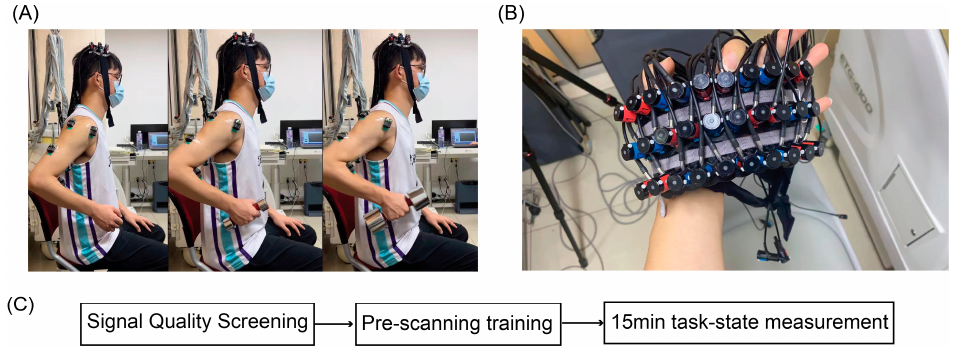
Figure 1. ( A ) Actual scenes of the experiment. The subject is seated on an armless chair, wearing loose clothes. ( B ) The high-density fNIRS probe. ( C ) The flow chart of experiments. Each subject passed through signal-quality screening (about 5 min), pre-scanning training (about 3 min), and task-state measurement (about 15 min). Table 1. Location of channels for subject 09.